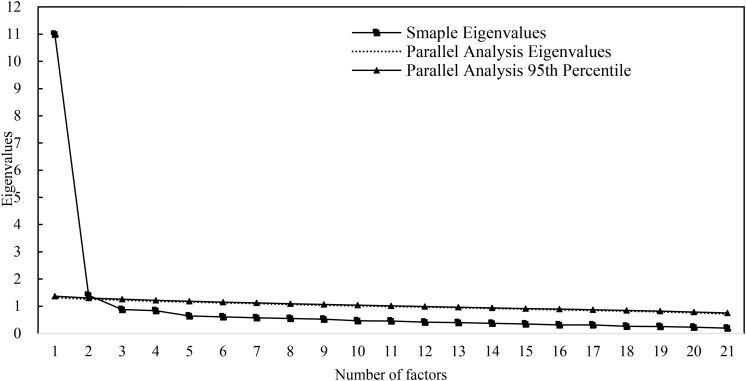
Scree plot for EFA and PA.